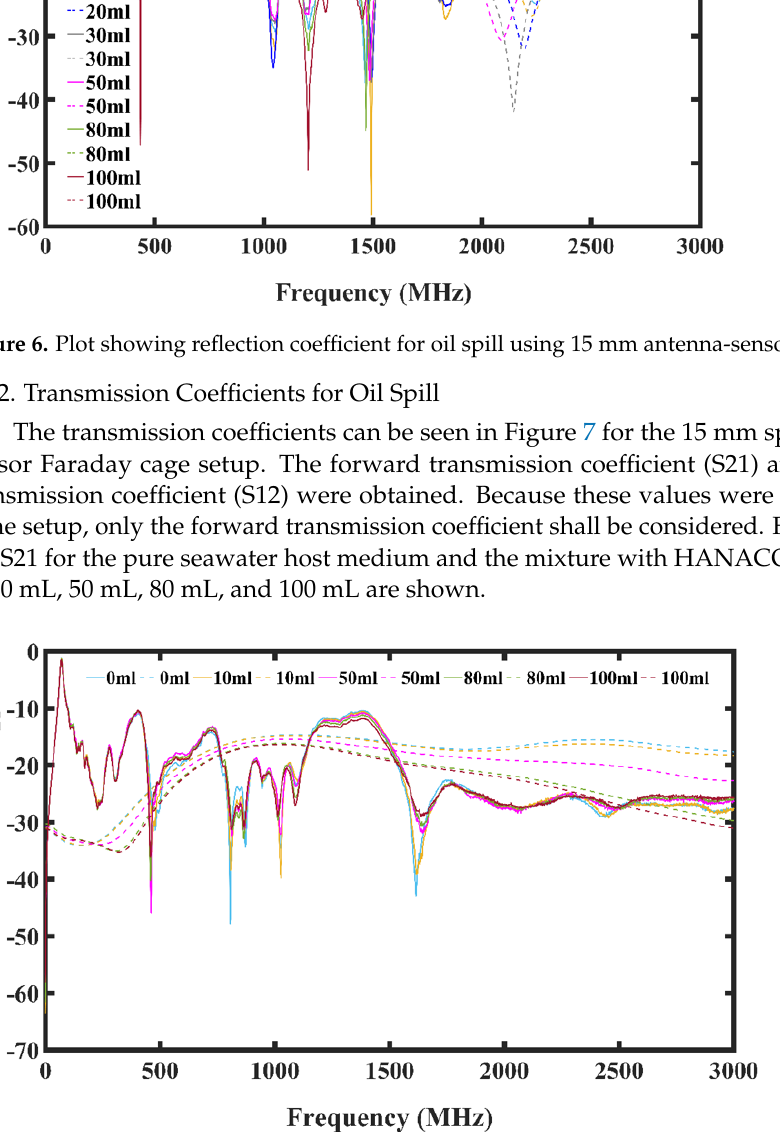
Figure 6. Plot showing reflection coefficient for oil spill using 15 mm antenna-sensors spacing.